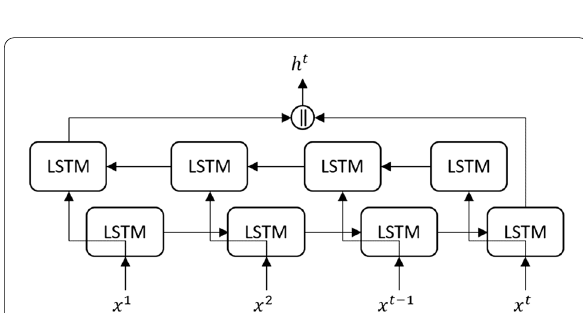
Fig. 6 Diagram illustrating the Bidirectional LSTM architecture with the standard LSTM cell, as illustrated in Fig.